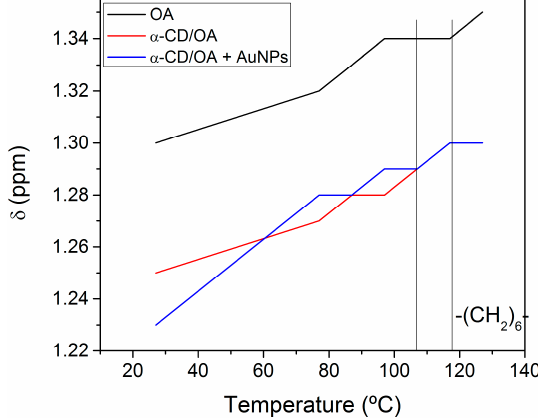
Figure 7. Graph of chemical shifts of (CH 2 ) 6 groups versus temperature. The black, red, and blue lines correspond to OA dissolved in DMSO- d 6 , α -CD/OA IC, and α -CD/OA IC conjugated with AuNPs, respectively.